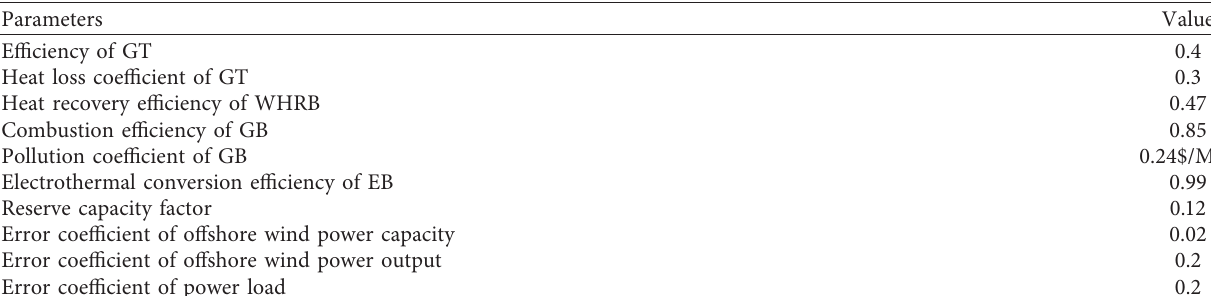
Table 3: Other parameters.